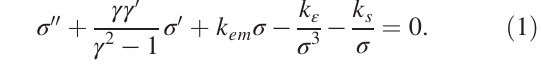
ffiffiffiffiffiffiffiffiffiffiffiffiffiffiffi p x 2 þ y 2